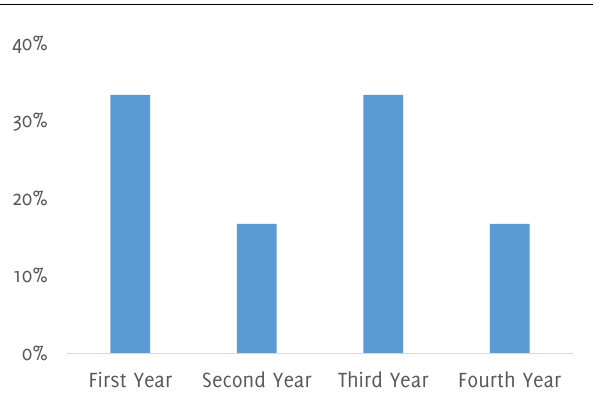
Figure 2 . Timing of OMP: Which year to Teach Medical Students the